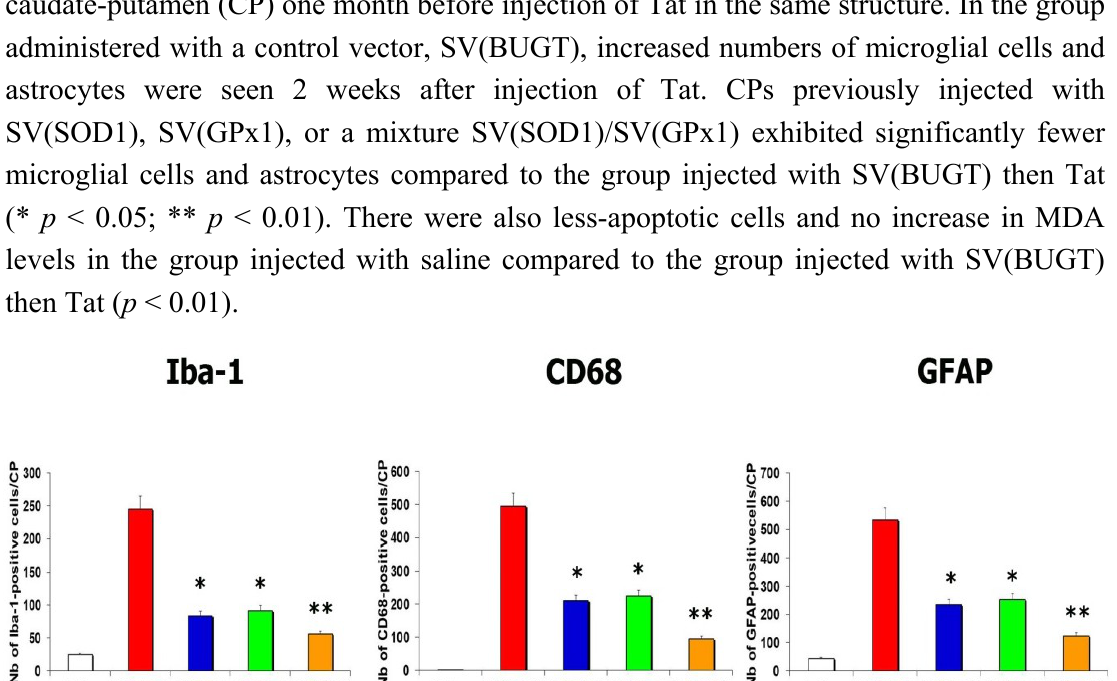
Figure 5. Gene delivery of antioxidant enzymes mitigates Tat-induced neuroinflammation. SV(SOD1), SV(GPx1), or a mixture SV(SOD1)/SV(GPx1), were injected in